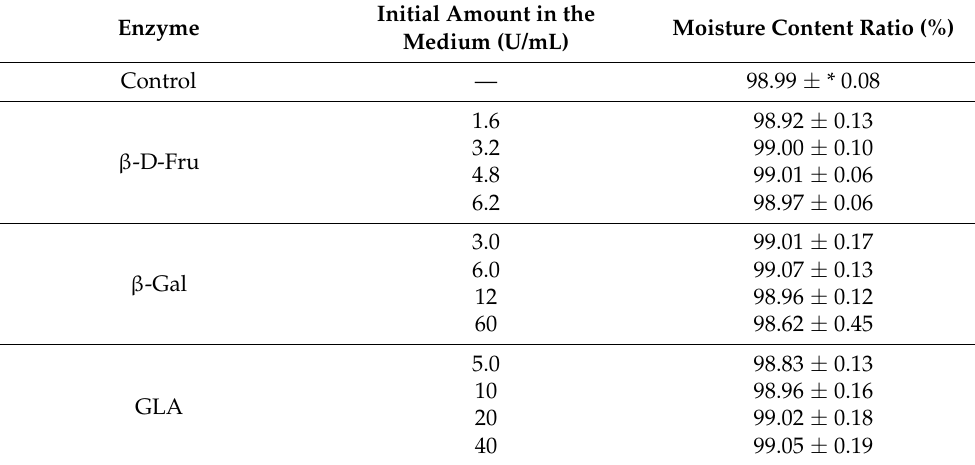
Table 3. The values of the moisture content ratio of BC depend on the initial number of enzyme units and the kind of polysaccharides used as carbon